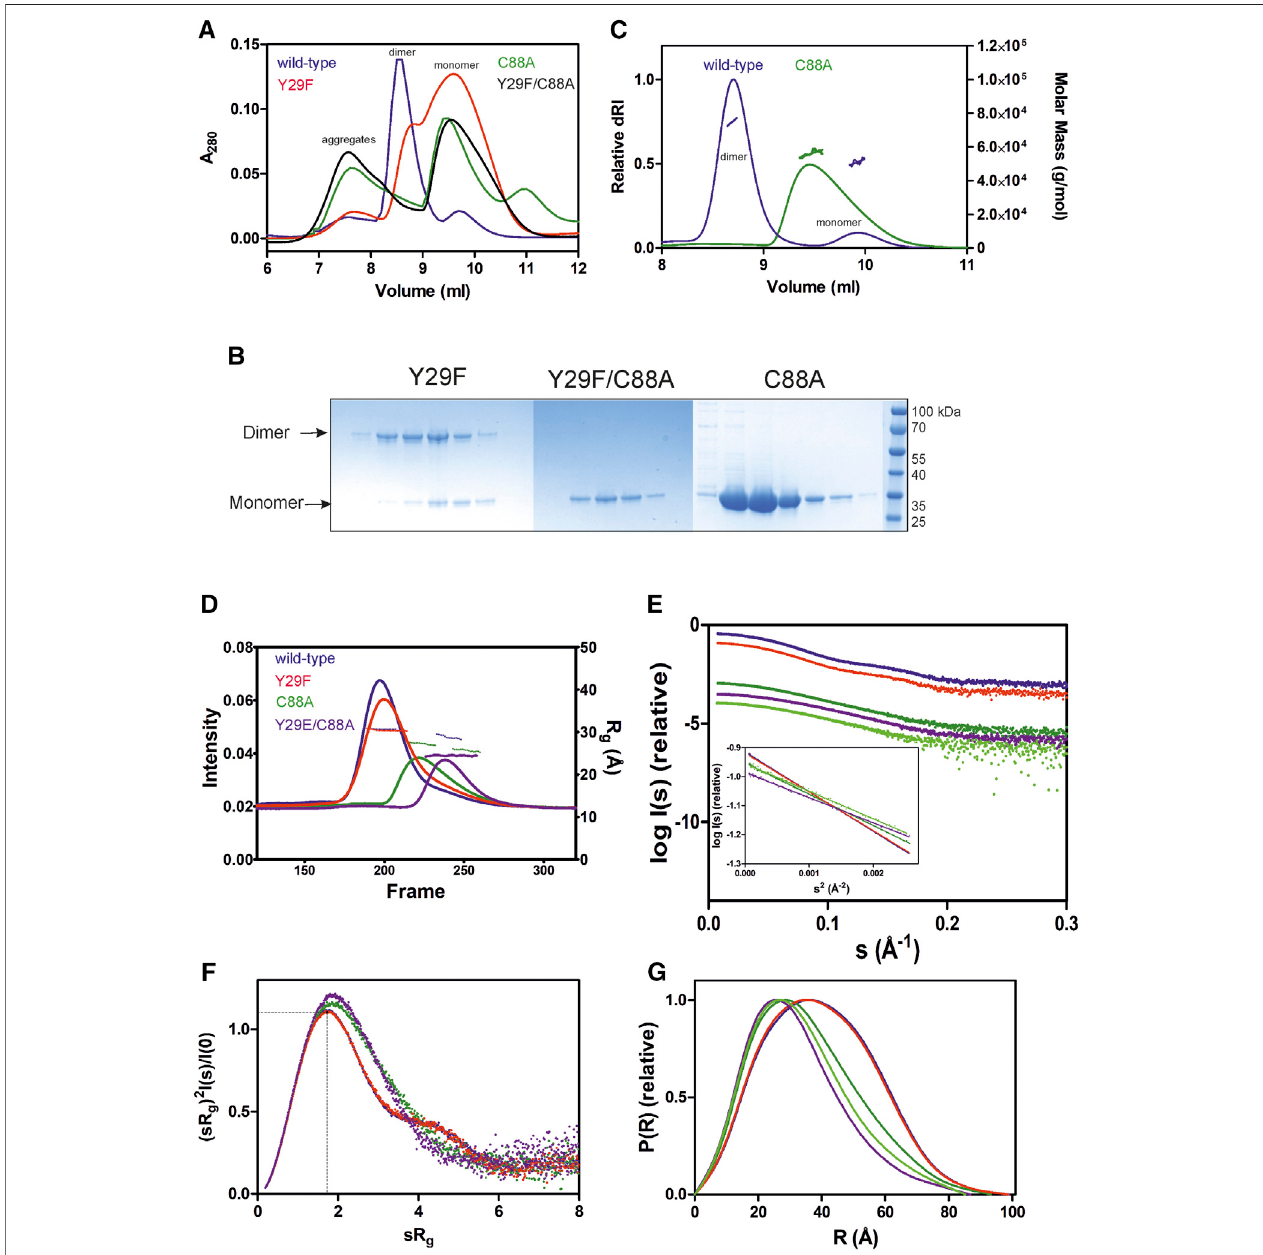
FIGURE 6 | The oligomerization of wild-type and mutant GDAP1 Δ 303-358 using SEC, SEC-MALS and SEC-SAXS. (A) SEC elution pro fi le of wild-type (purple), C88A (green), Y29F (dark orange), and Y29F/C88A (black) using column S75 increase 10/300 GL. (B) Non-reducing SDS-PAGE gel of mutants SEC elution. (C) SEC- MALS analysis of wild-type (purple) and C88A (green) using column S75 increase 10/300 GL. (D) SEC-SAXS elution pro fi les and R g plots. (E) Experimental scattering data (log(I s ) vs s) and linear fi ts in the Guinier regions (inset). The main and the second half of C88A peak are shown in dark and light green, respectively. (F) R g normalized Kratky plots, the dashed lines representing the maximum value ofa standard globular protein. (G) Distancedistributions p(r) plots ofwild-type GDAP1 Δ 303- 358 dimer (blue) and mutants Y29F (red), Y29E/C88A (purple), C88A main peak (dark green), and the second half (light green).